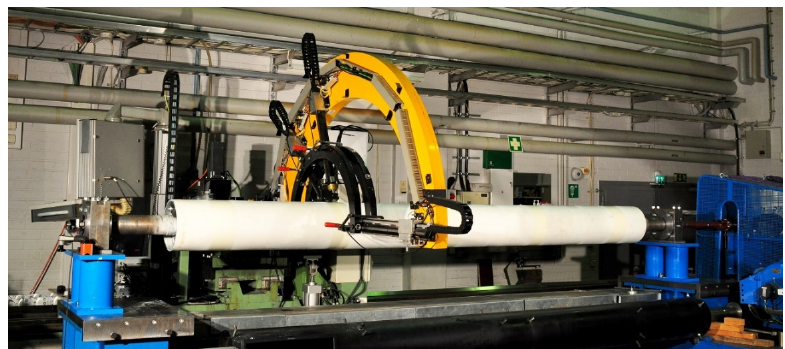
Figure 6. The measurement setup to capture dynamic responses was built on a commercial roll grinding machine [18].